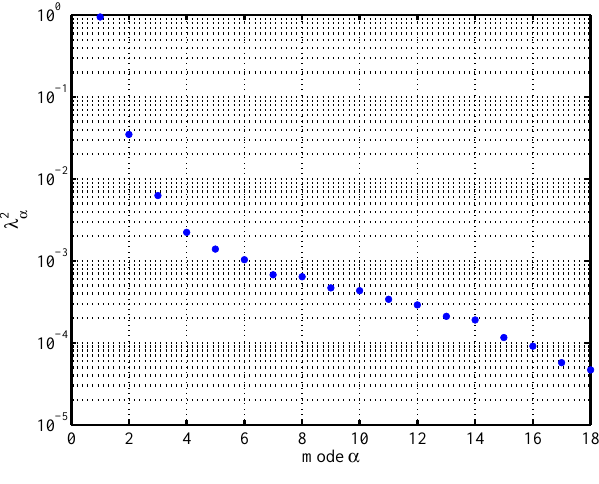
Fig. 2. Distribution of the variance of the 18 modes. Each weight is expressed as relative fraction of the total variance ( P n Most of the variability of the data set is concentrated in a few low order